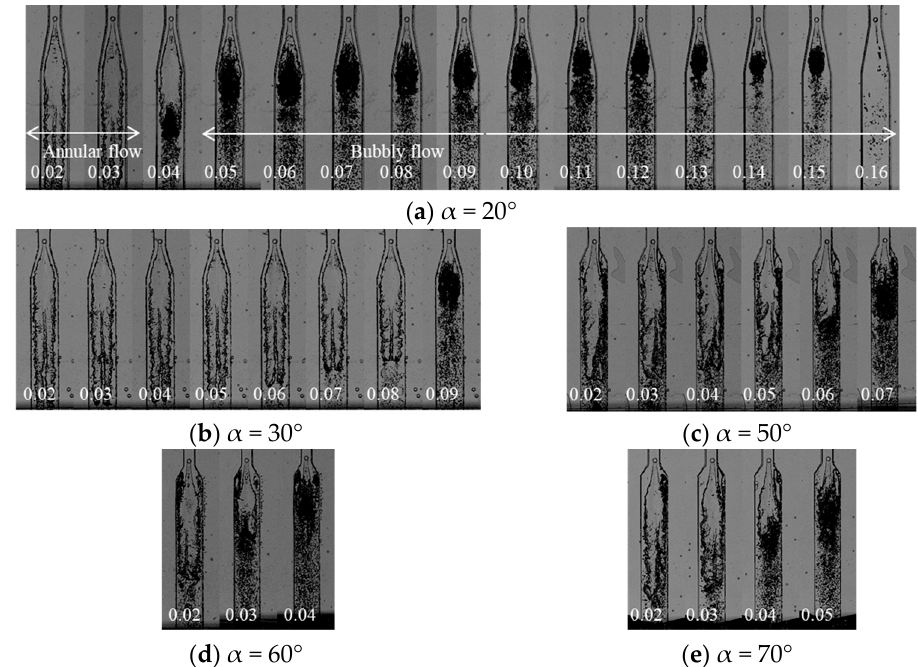
Figure 5. In the case of the annular flow, water–air two ‐ phase flows according to the pressure ratio at the diverging angle of ( a ) α = 20°, ( b ) α = 30°, ( c ) α = 50°, ( d ) α = 60°, ( e ) α = 70°.